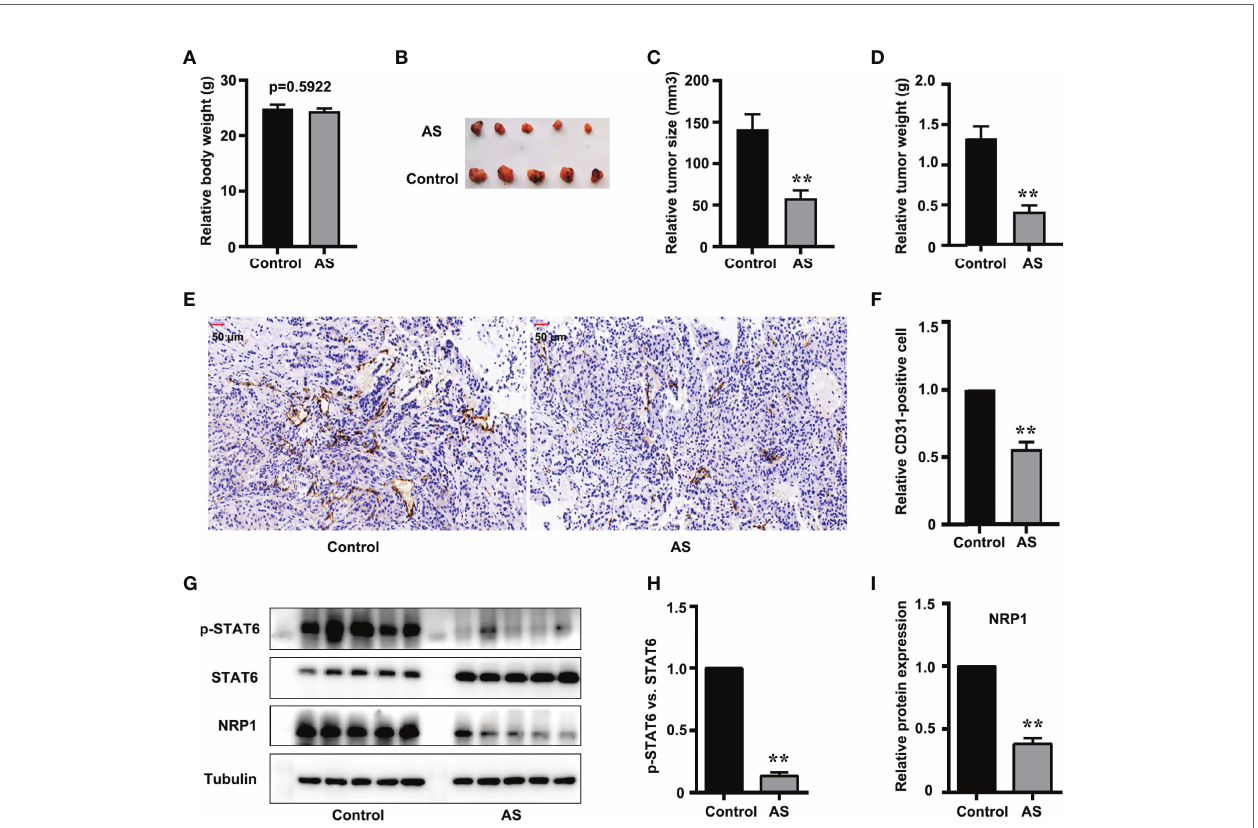
FIGURE 6 | Inhibition of STAT6 reduces xenograft growth and tumor angiogenesis in vivo . (A) Body weights were measured before all nude mice were killed. (B) Resected subcutaneous tumors from indicated A549 cell-injected groups in nude mice. (C, D) Tumor weight and tumor volume were measured, n=5, ** P <0.01 vs. control. (E, F) Vascular intensity by A549 cell-derived tumor treated with AS (25 mg/kg body weight) was evaluated by IHC with anti-CD31 antibody. Scale bar: 50 m m. n=5, ** P <0.01 vs. control. (G) Phosphorylation of STAT6, STAT6, and NRP1 were detected by western blotting in tumor tissue. (H) Relative STAT6 phosphorylation level normalized with STAT6, n=5, ** P <0.01 vs. control. (I) Relative NRP1 expression normalized with tubulin, n=5, ** P <0.01 vs. control.